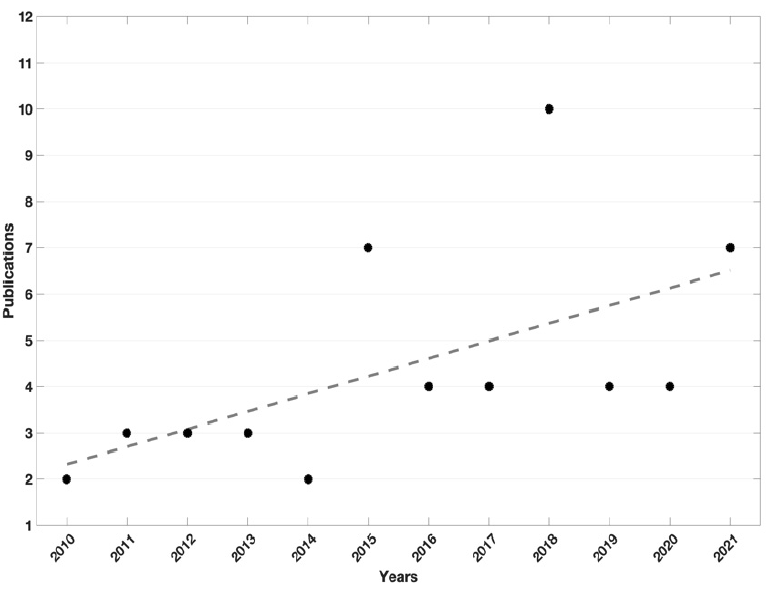
Figure 2. Black dots represents the number of publication per year, dotted line is the black dots trend.